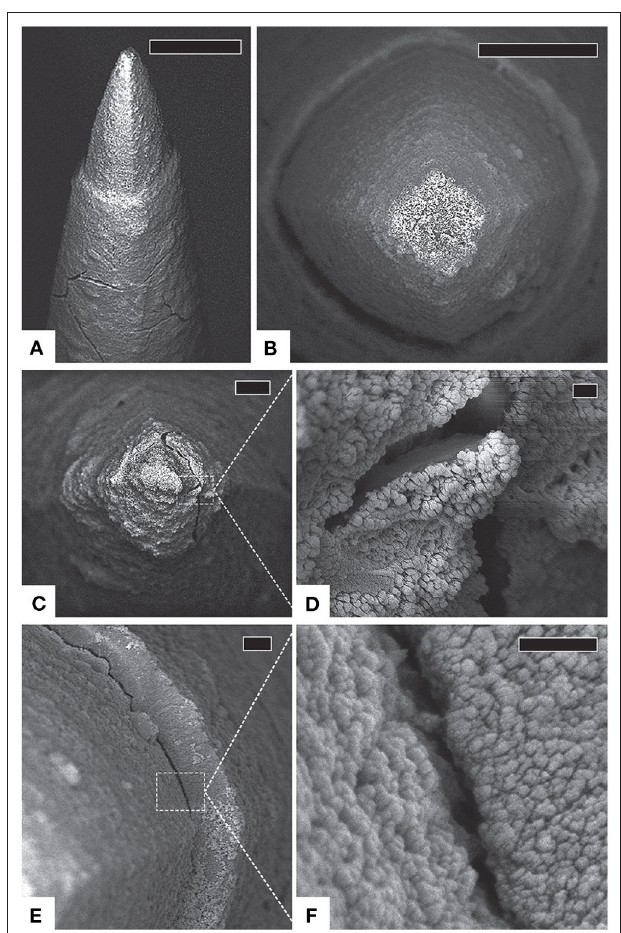
FIGURE 8 | Insulation deterioration and tip cracking. (A) Side view of a typical electrode with intact platinum [tip], cracked parylene [shaft], and substantial fibrosis, scale 20 µ m. (B) Top view of another typical electrode with intact platinum and thick, uniform fibrosis encapsulation, scale 10 µ m. (C) An electrode tip with thick encapsulation tissue, scale 3 µ m. (D) Detail of cracked platinum tip, scale 200 µ m. (E) Delaminating parylene interface, scale 1 µ m. (F) Detail of parylene delamination, scale 200nm. Figure and caption reproduced with permission from Barrese et al. (2016). © IOP Publishing. All rights reserved. Tip cracking and insulation deterioration are irreversible, but potentially compensable with algorithmic